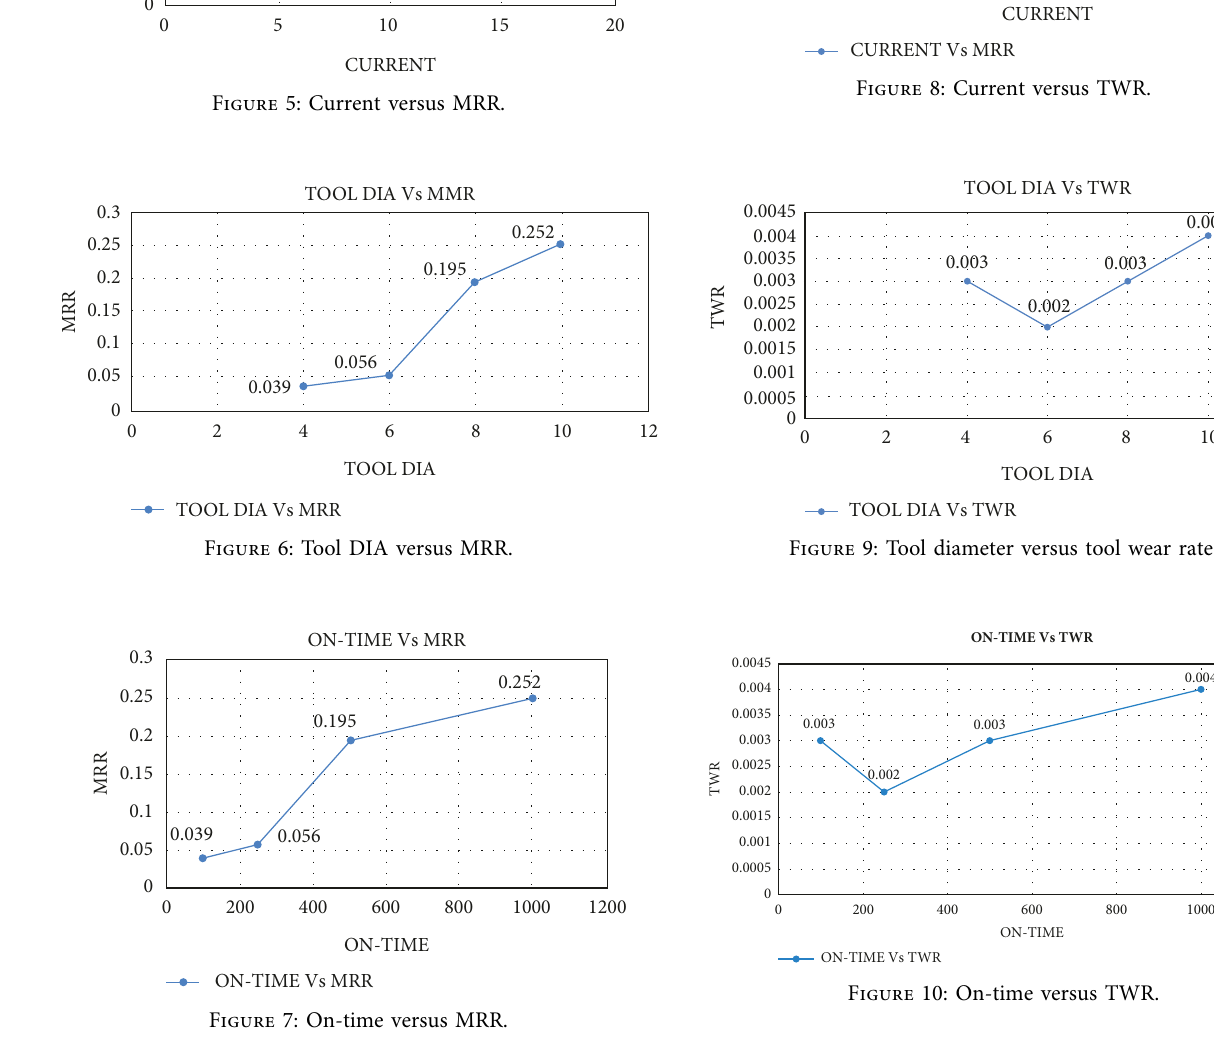
Figure 7: On-time versus MRR.